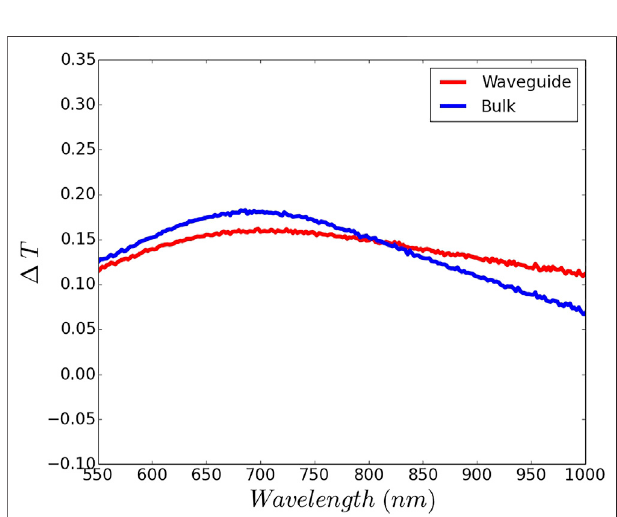
FIGURE 3 | nc-YSZ transmittance changes after 24 h annealing at the waveguide zone and at a region far away from waveguide zone within the same